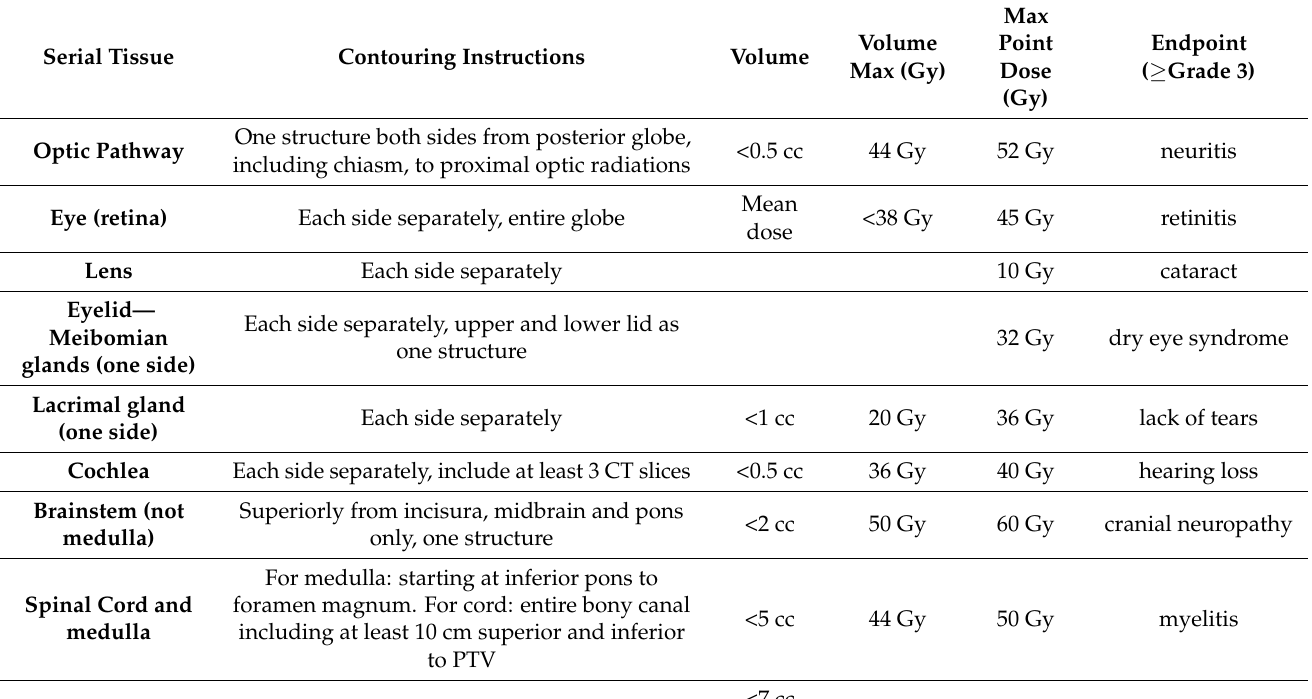
Table 2. Tolerance doses in 30 fractions (conventional